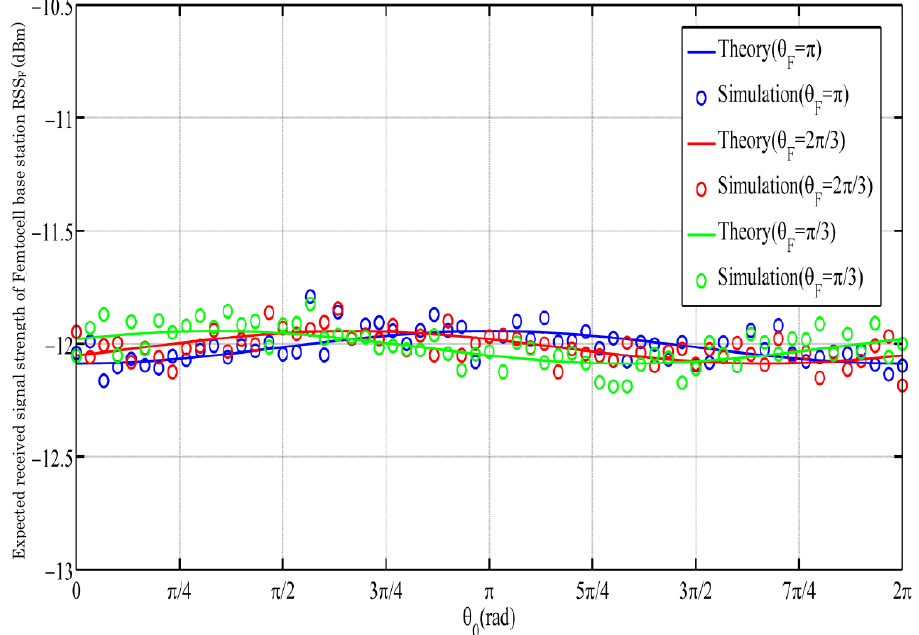
Figure 8. When r = 2 m/s, expected received signal strength of femtocell base station RSS F